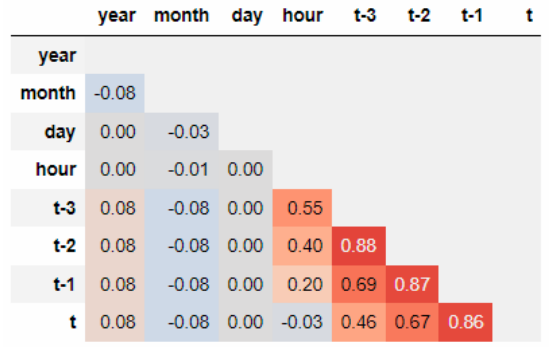
Figure 7. Representation of the accumulative sum of energy production on a daily basis.